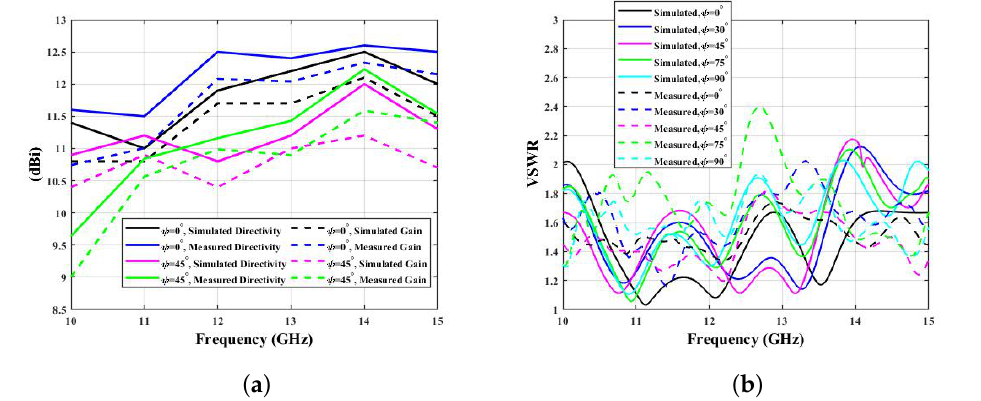
Figure 10. ( a ) Distribution of simulated and measured peak directivity and gain values for 0 ◦ , 45 ◦ angles of rotation of WR-75 waveguide. ( b ) Simulated and measured voltage standing wave ratio (VSWR) plots for 0 ◦ , 30 ◦ , 45 ◦ , 75 ◦ and 90 ◦ angles of rotation of the WR-75 waveguide.